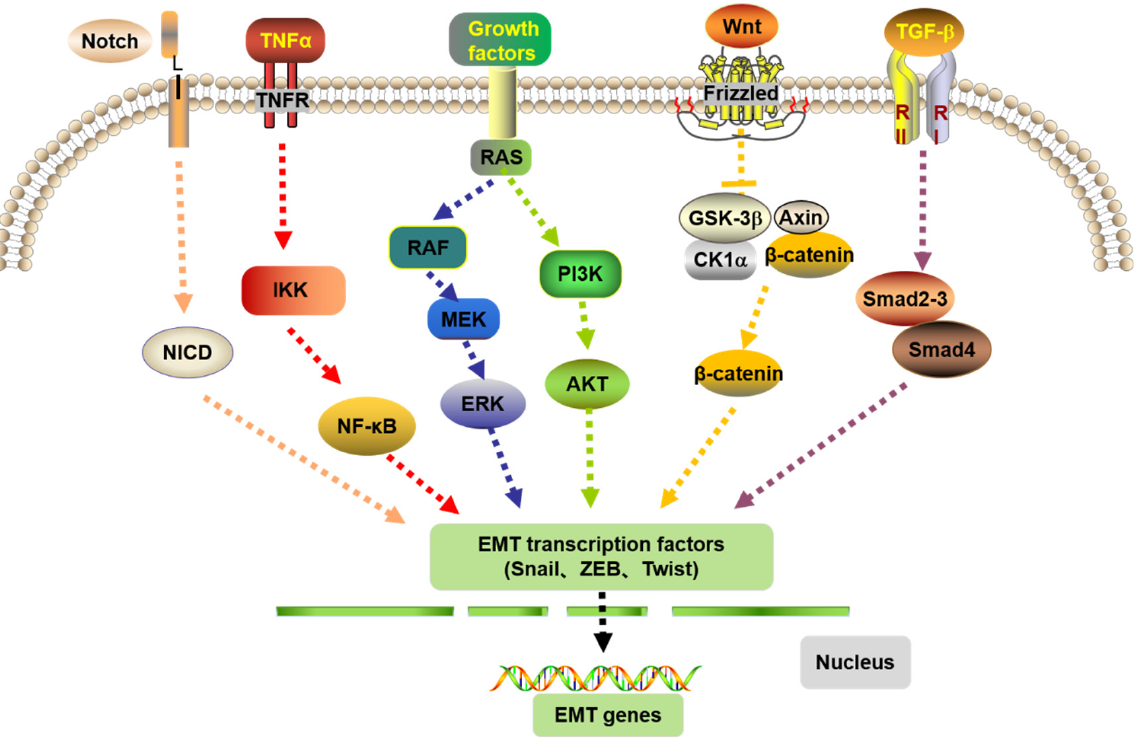
Figure 3. EMT-transcriptional factors activated by extracellular and intracellular pathways to regulate EMT. From left to right: Notch, NF- ĸ B, RAF/ERK, PI3K/Akt, Wnt/ β -catenin, TGF- β . Dickkopf-1 (DKK1) is an inhibitor of the Wnt signaling pathway that can inhibit CRC progression by inhibiting EMT [65]. Canel et al. [66] found that the Src/FAK signaling prevents the movement of tumor cells in vitro and in vivo, and the FAK inhibitor PF-562271 inhibited tumor cell spread and metastasis. Polysaccharide-K (PSK) was found to modu- late the biological activities of TGF-1 and TGF-2 [67]. Thus inhibiting the EMT process, the randomized clinical experiments also showed that PSK plays an effective role in the adju- vant treatment of CRC [68]. Hou [37] revealed the unknown mechanism of LHPP as a tu- mor suppressor in CRC metastasis, where E-cadherin was significantly increased with LHPP overexpression. As a key mediator of the classical Smad-signaling TGF- β /Smad3 phosphorylation, LHPP specifically inhibited EMT, providing new perspectives for the treatment of CRC. 4.4. EMT and the Correlated Factors The invasion and metastasis-related factors are crucial points in CRC treatment and drug development. In the study of the mechanism of basement membrane turnover in malignant CRC progression, Spaderna et al . [44] proposed that the progression of base- ment membrane loss and the differentiation of epithelial cell phenotype upon ZEB1 knockdown is similar to MET, and targeting relevant EMT-related transcriptional re- pressors in ZEB1 or other tumors may be a choice with therapeutic potential to prevent malignant metastatic progression. Studies by Hu et al . [69] verified that HDAC2 acted as a metastasis suppressor in CRC by inhibiting the expression of EMT, H19, and MMP14. Although the development of anticancer drugs targeting HDACs highly expressed in many tumors has been conducted for many years, clinical trials have shown that the single application of HDAC inhibitors are ineffective in patients with solid tumors, including CRC. Therefore, more studies of HDAC inhibitors in solid tumors need to be carried out. As an EMT-related factor [25], cMET promotes EMT in CRC by inhibiting RKIP expres- sion. In this case, patients with c-MET downregulation and RKIP upregulation showed the longest overall survival and progression-free survival time. Thus, targeting RKIP to